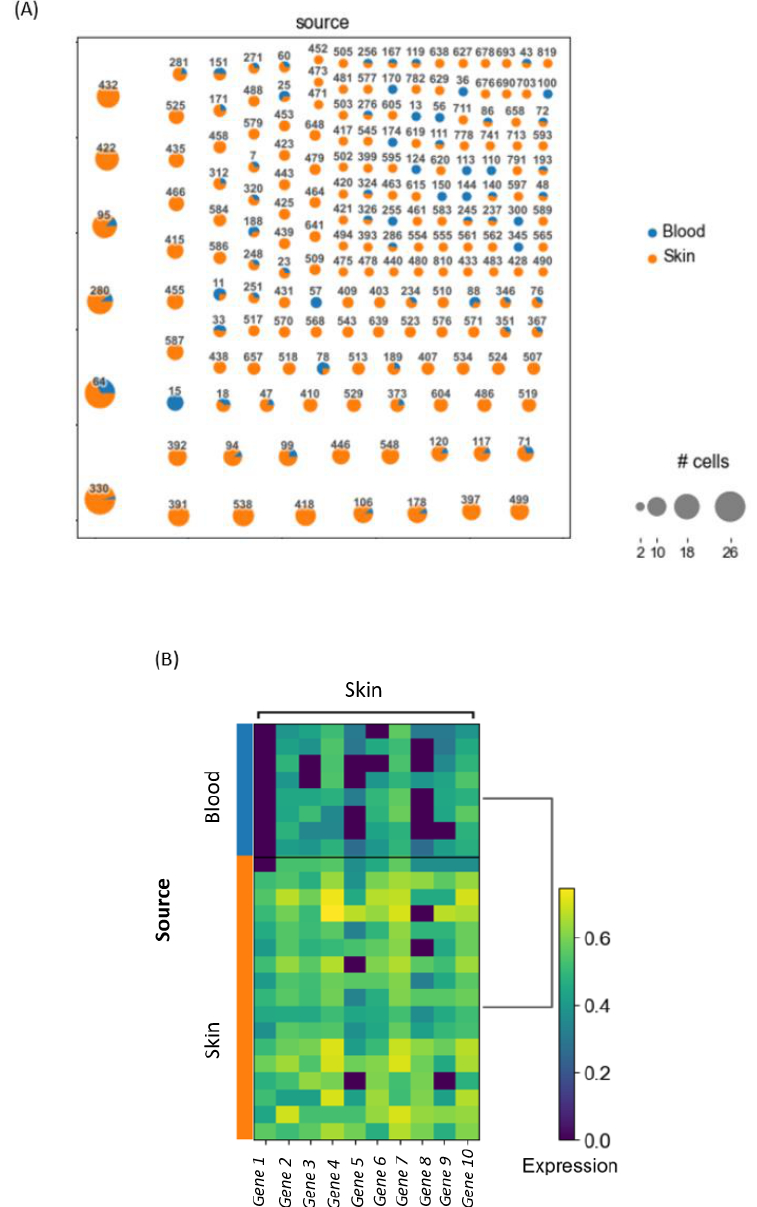
Figure 3. ( A ) Example of a clonotype network constructed by Scirpy, using the default parameters in order to showcase all clones found in the dataset comprising T cells from matched skin and blood of a given patient. ( B ) Heatmap showing the top 10 differentially expressed genes for the shared clone with the clone ID 64 (as depicted in ( A )), using default parameters in Scirpy.